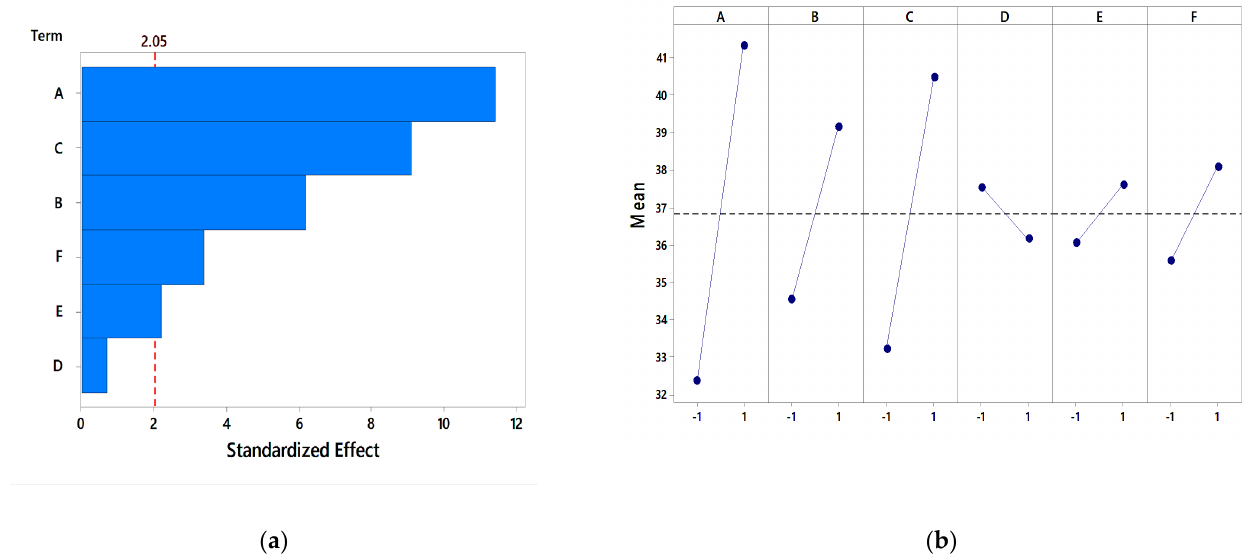
Figure 5. Analysis of the PB design for carbon sources ( a ) Pareto chart, ( b ) main effect plot.